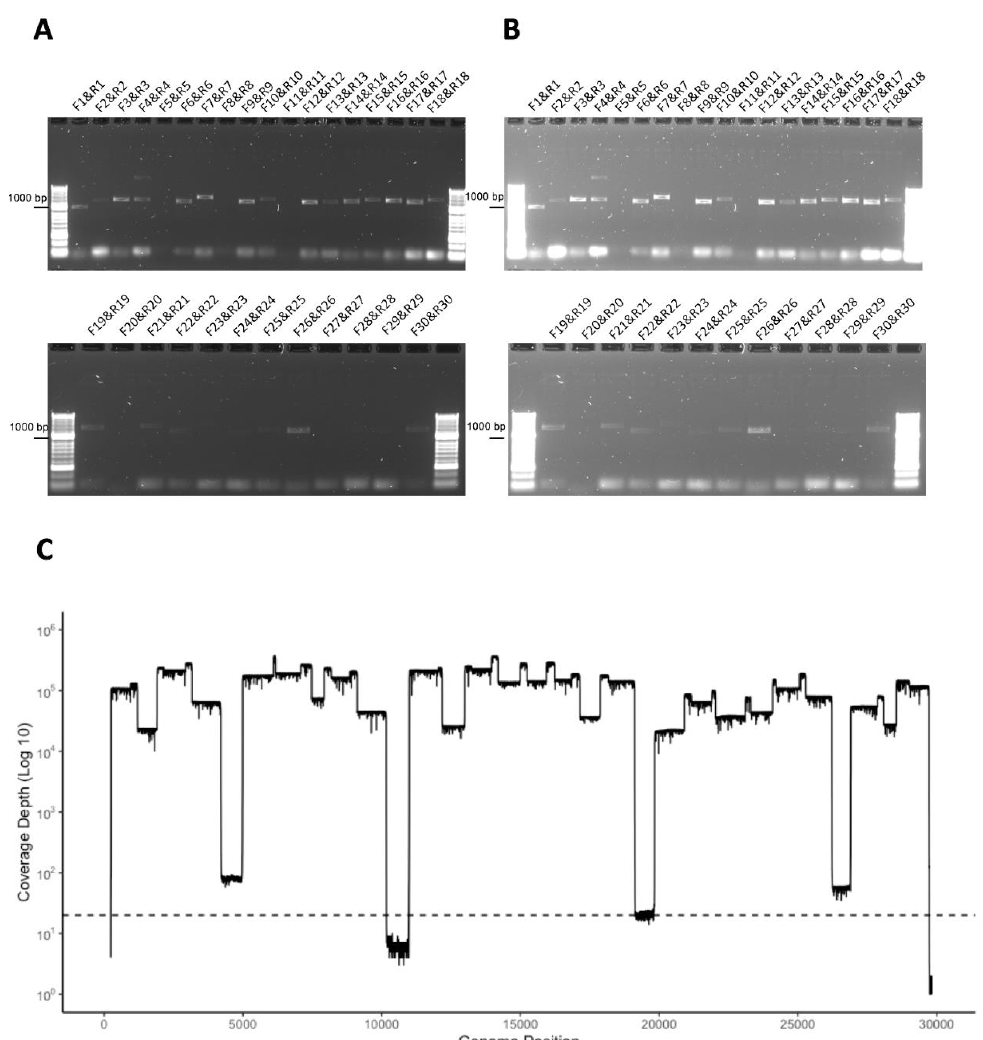
Figure 3. ( A , B ) Agarose gel electrophoresis analysis of amplicons generated by RT-PCR from RNA isolated from a nasopharyngeal swab taken from patient REMRQ0002, who had COVID-19, and diagnosed positive for SARS-CoV-2 by a laboratory-based test. Primer pairs are indicated above each amplicon. Note that the image in ( B ) is the same image as ( A ) but the brightness has been enhanced post-image capture in order to more clearly show amplicon products. ( C ) The amplicon products were purified and sequenced on a single flow cell using an Oxford Nanopore MinION. Shown are the number of reads that map ( y -axis) to each amplicon across the SARS-CoV-2 genome from 5′ to 3′ ( x -axis).